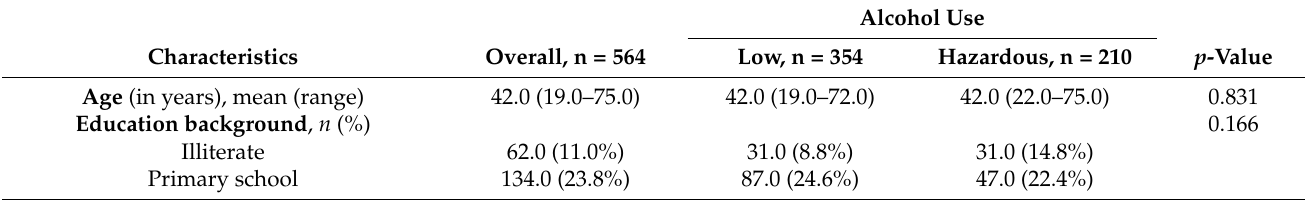
Table 1. Sample characteristics at T1 among intervention participants (n =